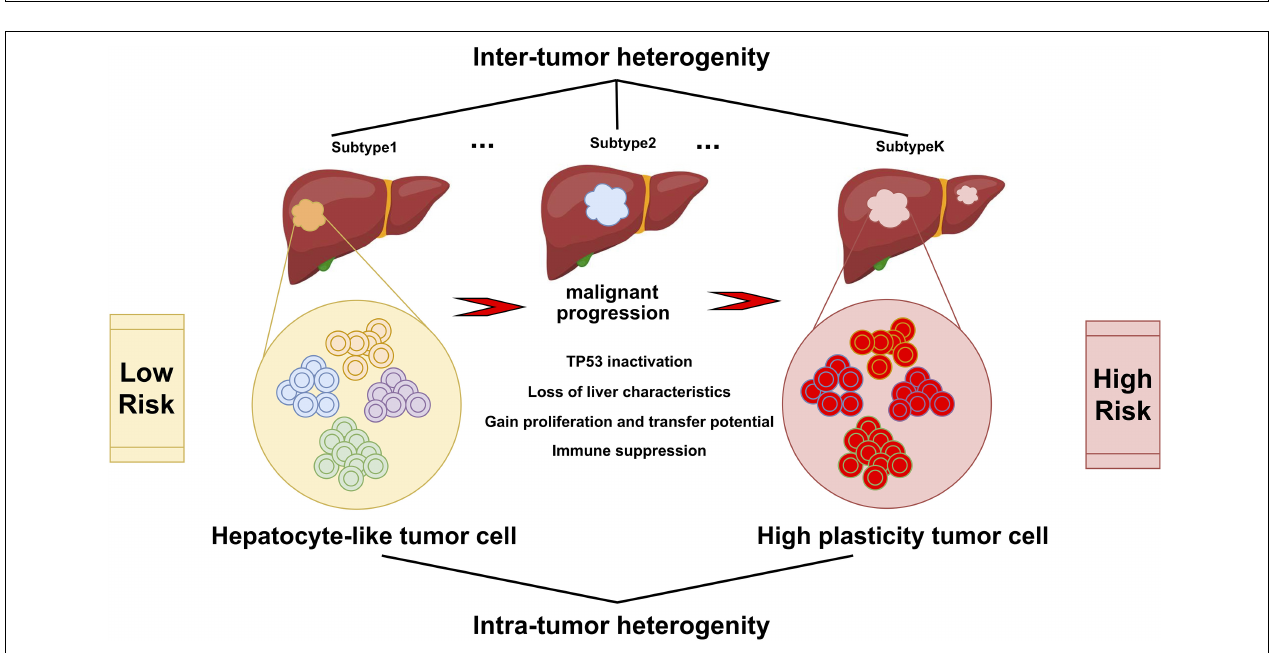
FIGURE 7 | GSEA enrichment analysis. (A) The enrichment plot of upregulated gene sets in low-risk group. (B) The enrichment plot of downregulated gene sets in low-risk group.